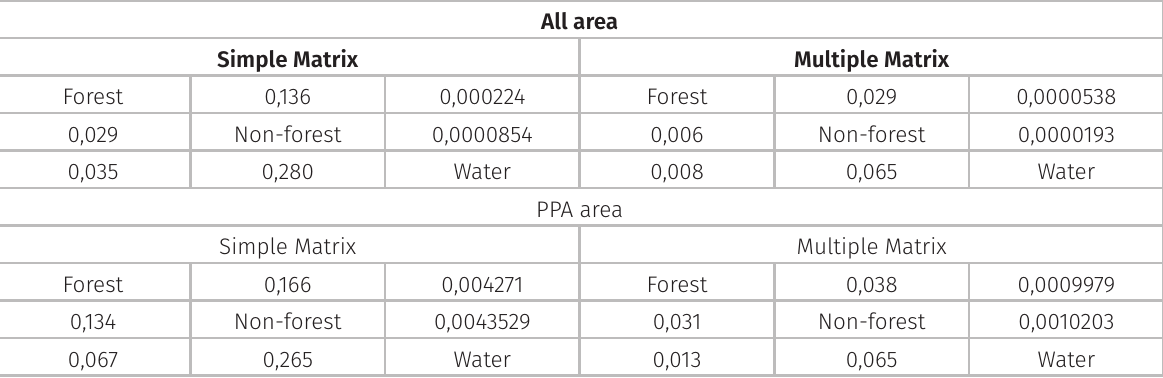
Table II. Analysis report of the transition matrix for the entire permanent preservation area and all area referring the period 2013 to